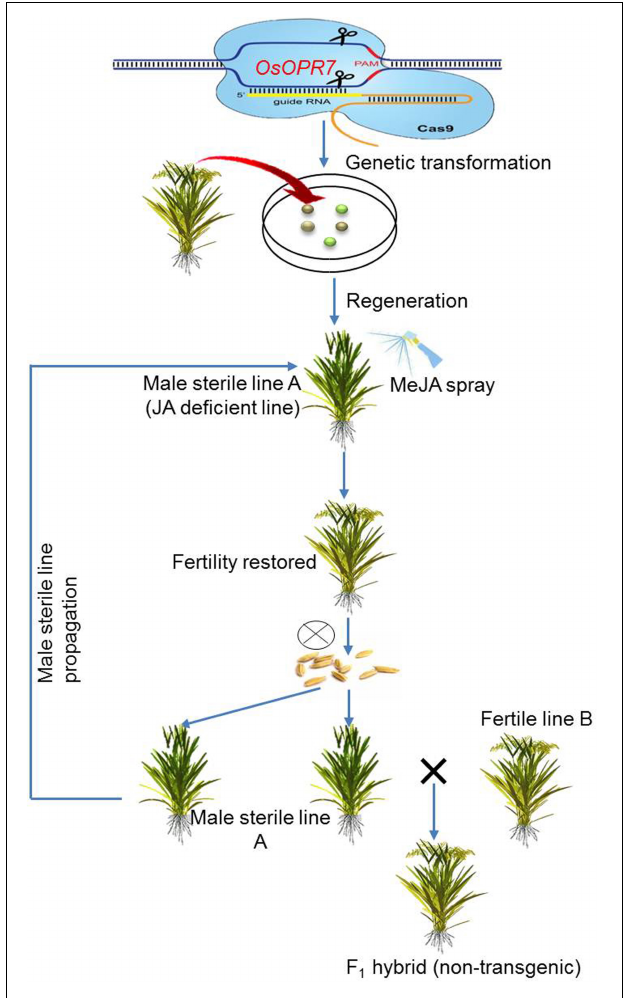
FIGURE 7 | Phytohormone genic male sterility system for two-line hybrid production. Exogenous application of MeJA on jasmonic-acid-deficient male sterile mutants rescues the fertile phenotype for sterile line propagation and hybrid production. JA, jasmonic acid; MeJA, methyl jasmonate.